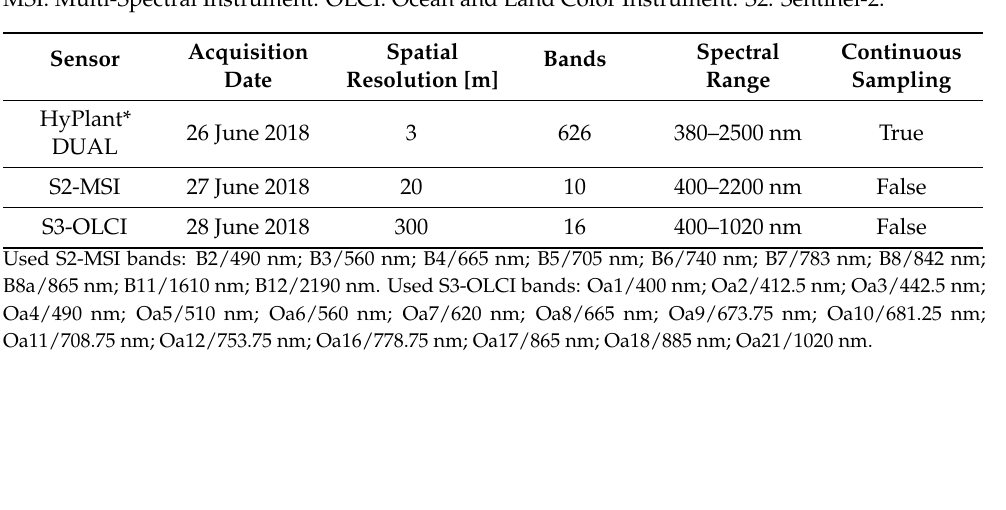
Table 1. Used imagery for the multiscale validation analysis. (*) For the purpose of the study, the Hyplant DUAL data were resampled to the S3-OLCI spectral resolution (referred as Hyplant*). MSI: Multi-Spectral Instrument. OLCI: Ocean and Land Color Instrument. S2: